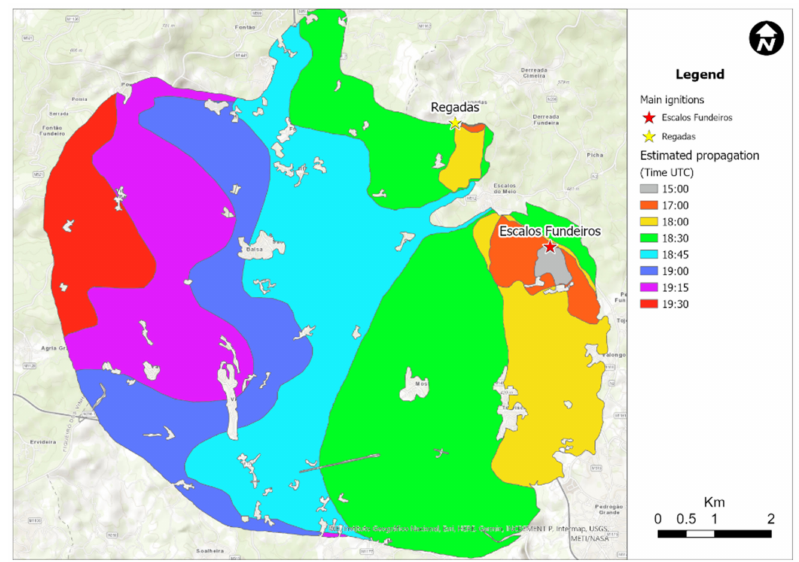
Figure 16. Approximate evolution of the fires between 19:30 and 20:30 UTC, as per ground survey. RE and EF represent Regadas and Escalos fire ignition,